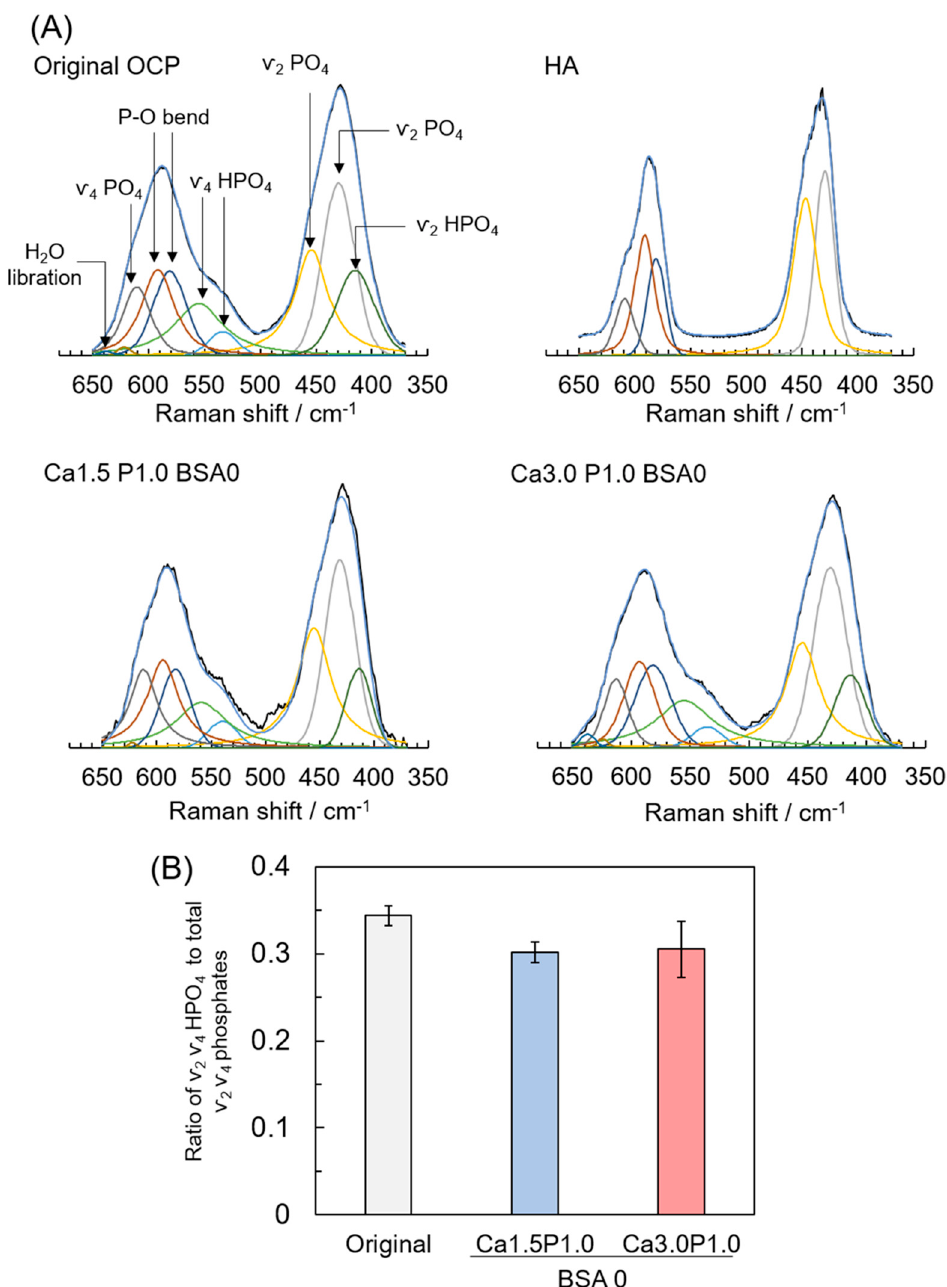
Figure 6. Raman spectra curve fitting of original OCP, hydroxyapatite (HA) and OCP after incubation with Ca1.5P1.0 or Ca3.0P1.0 solution without BSA ( A ). Integrated intensity ratio of ν 2 , ν 4 HPO 4 to the total phosphate vibration ( ν 2 , ν 4 HPO 4 + ν 2 , ν 4 PO 4 ) estimated by a curve fitting of Raman spectra for OCP before and after incubation ( B ). Mean values were obtained from three independent experiments (n = 3).